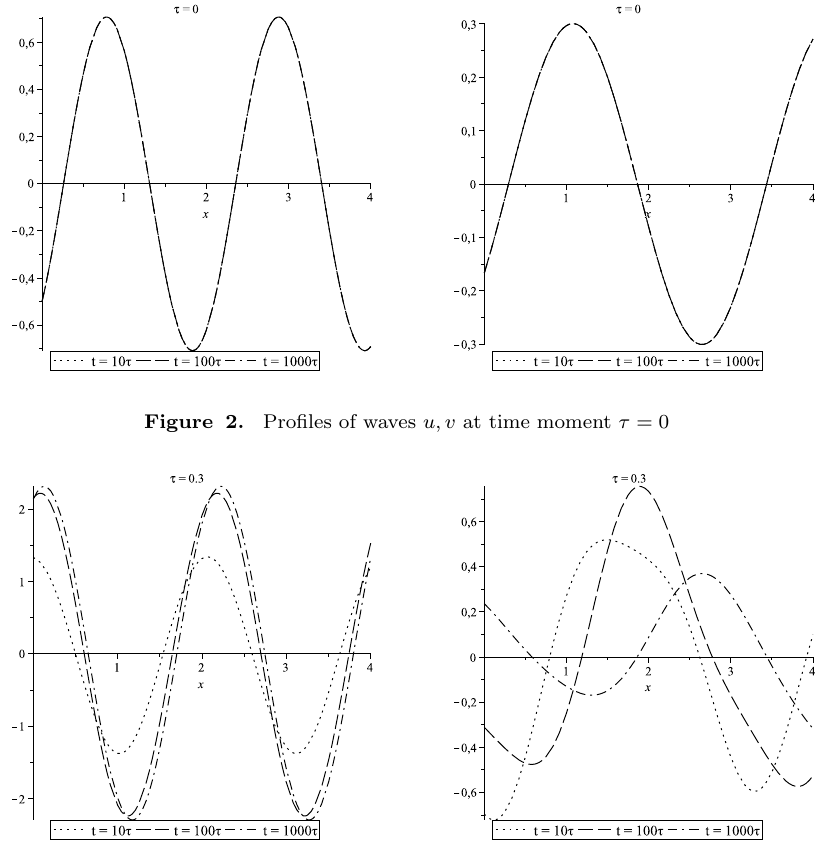
Figure 3. Profiles of waves u,v at time moment τ = 0 .